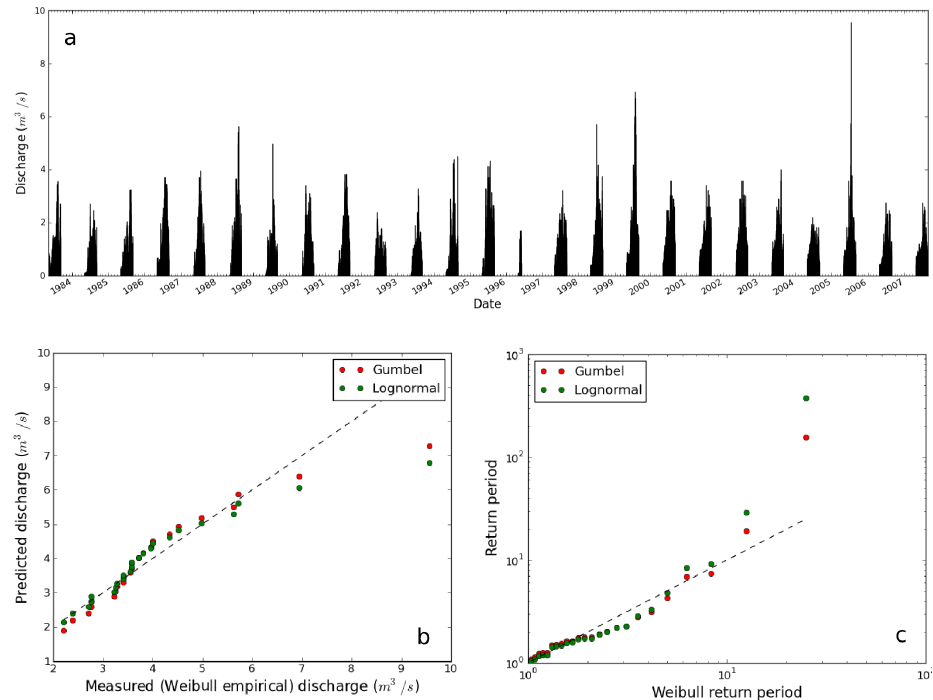
Fig. 12. River hydrology (a) Daily hydrograph of the Urumqi River during 25 years. (b) Comparison between the measured (Weibull empirical) and the predicted discharge using a lognormal or a Gumbel probability distribution. (c) Comparison between the Weibull empirical return period and the lognormal or Gumbel return periods for the Urumqi